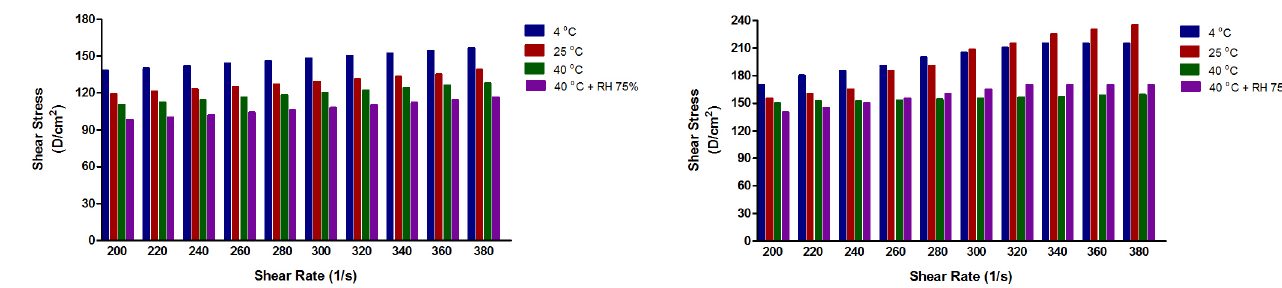
FIGURE 9 - Rheogram of CF Emulsion at different temperature after 2 months. Temperatures tested were 8 o C (blue bars), 25 o C (red bars), 40 o C (green bars), and 40 o C + 75% RH (violet